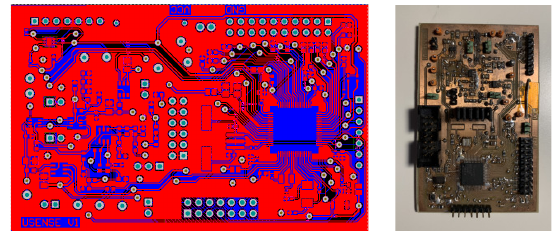
Figure 24. Designed and manufactured PCB.